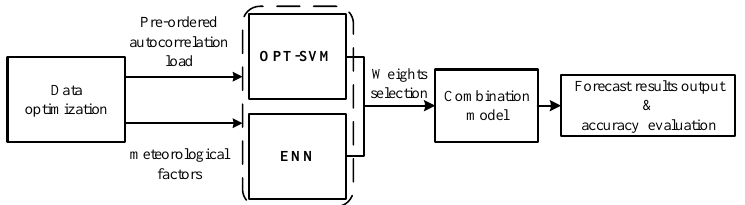
Figure 2. Framework of the proposed